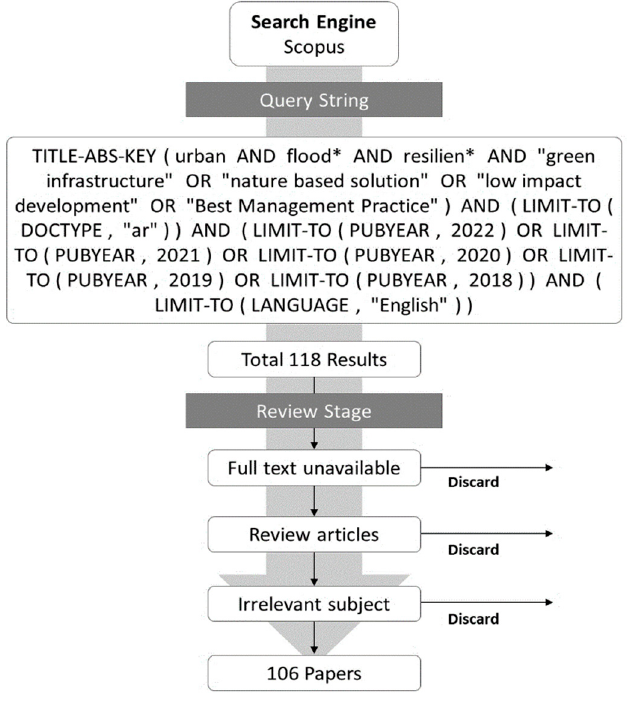
Figure 1. The literature search structure to obtain the final results for the analysis.